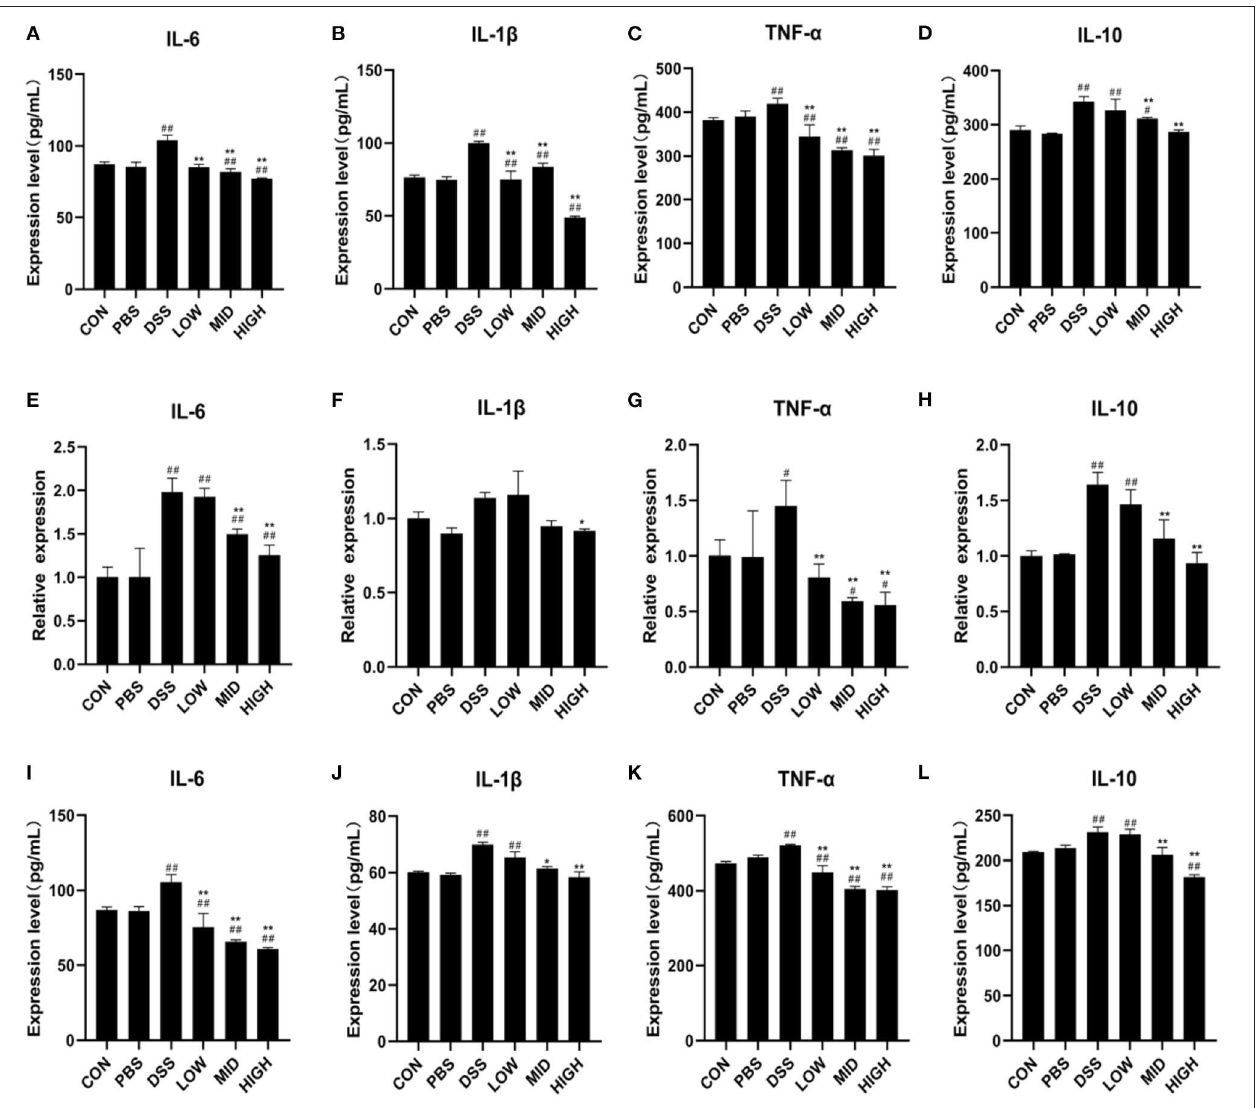
FIGURE 8 | The effects of BTL-1 on blood routine examination and expression of inflammatory factors in DSS-induced IBD mice. The effects of BTL-1 on inflammatory factors in serum (A–D) and intestinal tissue as measured by qPCR (D–H) and ELIS A (I–L) . The results were expressed as the means ± SEM of n = 3. # P < 0.05, ## P < 0.01, compared to control group, * P < 0.05, ** P < 0.01 compared to DSS